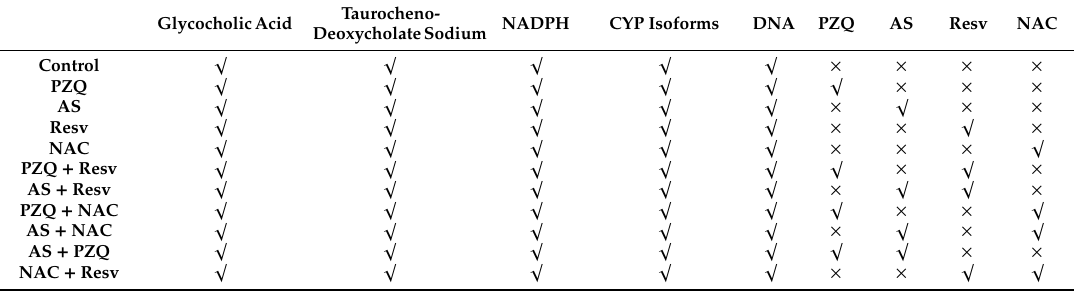
Table 2. Constituents of the reaction mixtures used for evaluation of inhibition of precursor metabolites and DNA adducts formation by novel therapeutic approach.